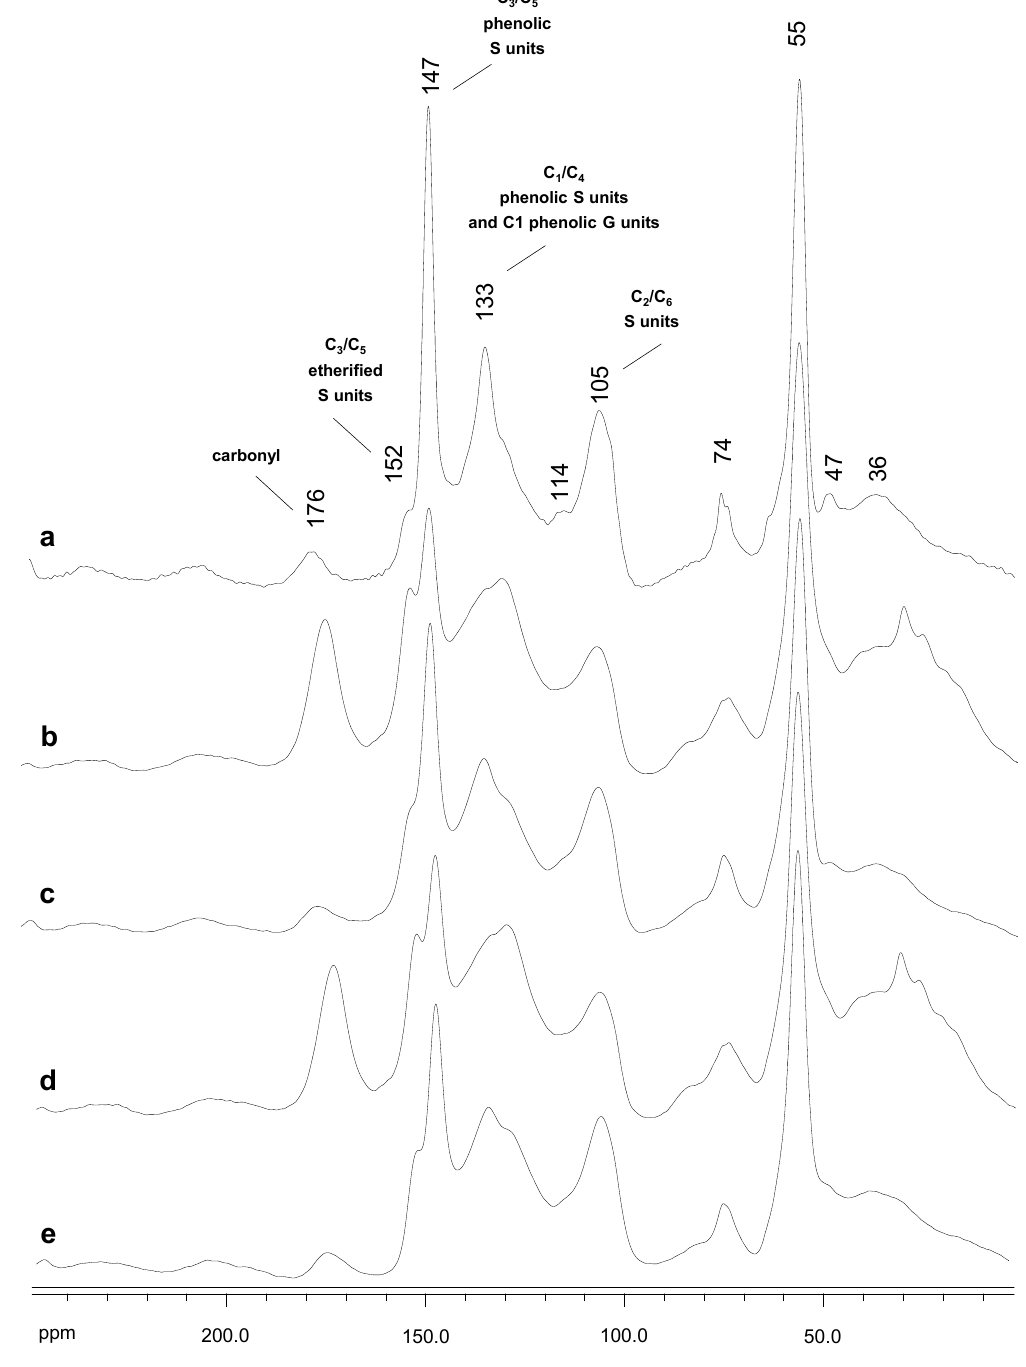
Figure 6. 13 C NMR spectra, δ C 0.0–250.0 ppm, of untreated Kraft lignin ( a ) and the resulting treated lignins with SiLA ( b , SiLA ‐ KL1; d , SiLA ‐ KL2) and MtL ( c , MtL ‐ KL1; e , MtL ‐ KL2) laccases.